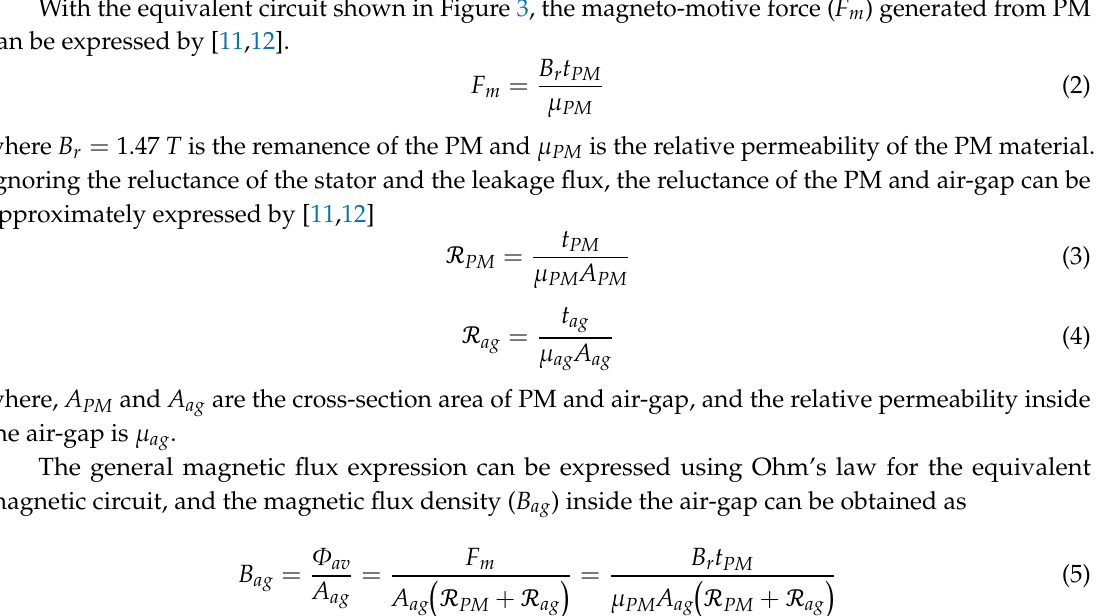
Figure 3. Lumped-circuit element based magnetic circuit model of the VCM, where 𝑡 (cid:3017)(cid:3014) , 𝑡 (cid:3028)(cid:3034) , 𝑡 (cid:3028) ,